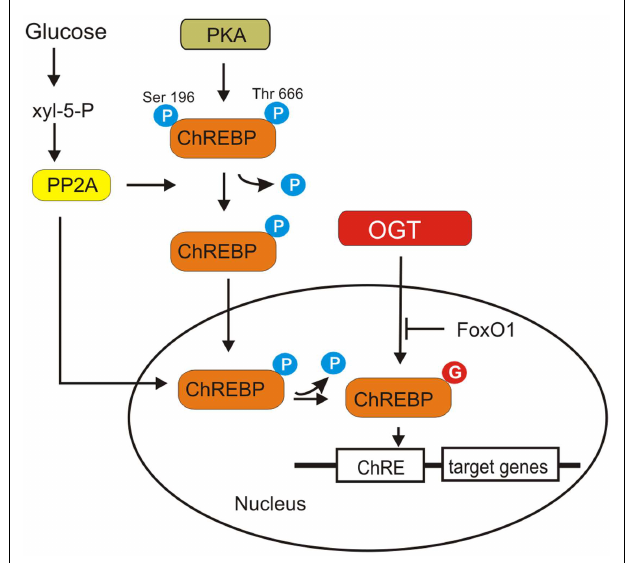
FIGURE 7 | ChREBP activation is shown . ChREBP is phosphorylated by PKA. Dephosphorylation of Ser196 andThr666 ChREBP is required for its translocation into the nucleus and DNA binding. A particular isoform of protein phosphatase 2A (PP2A), selectively activated by Xyl-5-P, an intermediate of pentose phosphate pathway, is responsible for both cytosolic and nuclear dephosphorylation of ChREBP. O -GlcNAcylation of ChREBP increases its protein level and transcriptional activity. Overexpression of FoxO1 attenuates ChREBP